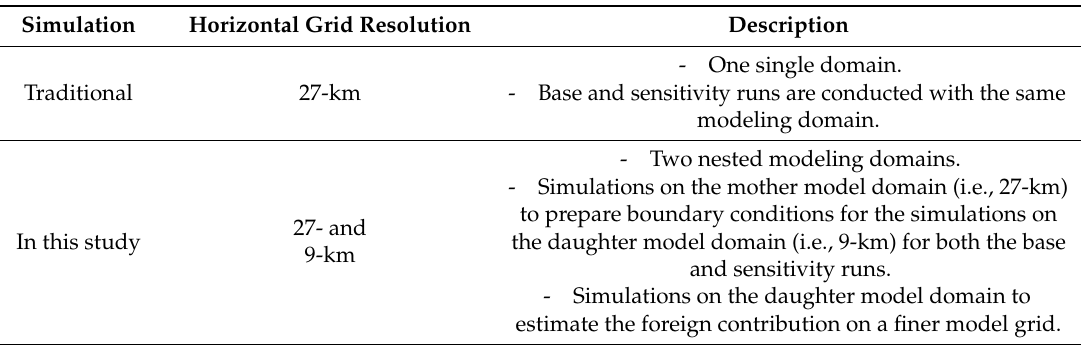
Table 2. Details of the two sets of air quality